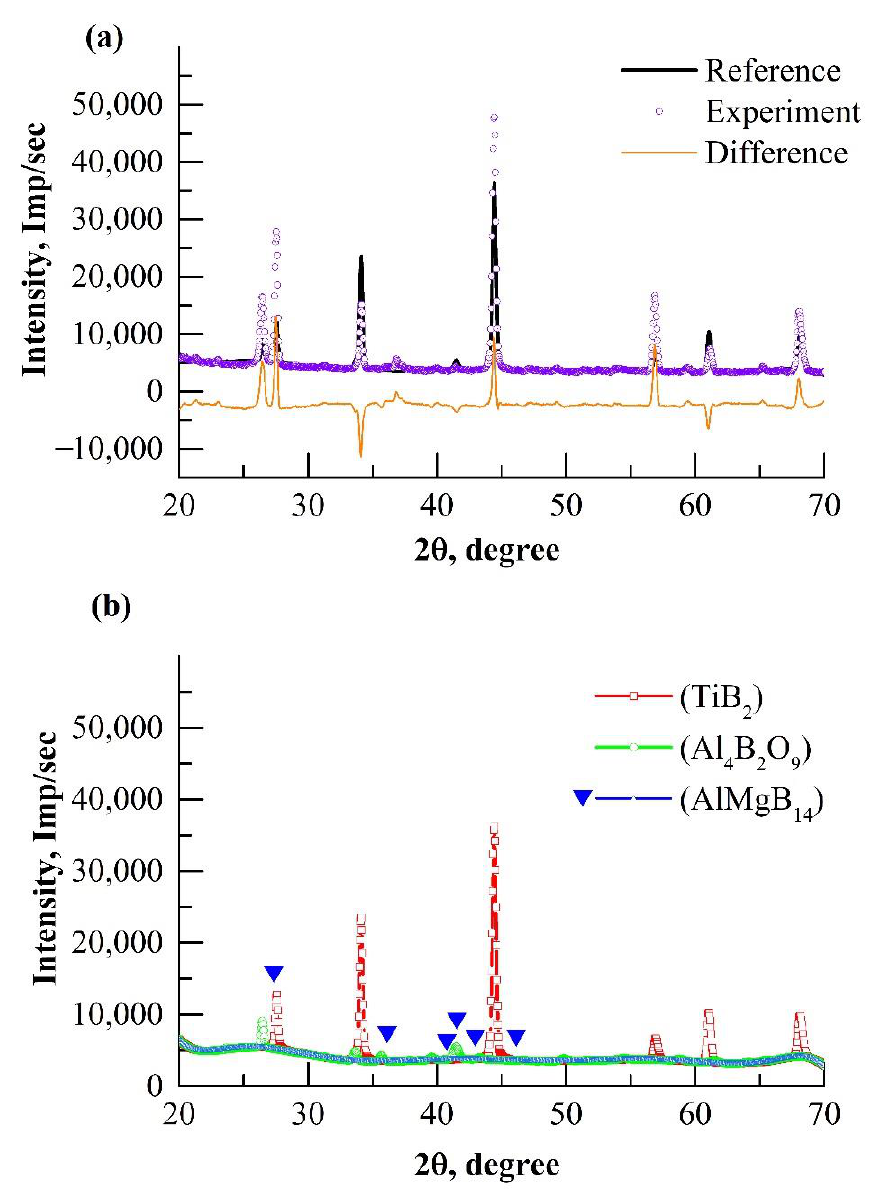
Figure 2. XRD patterns of the spark plasma sintered AlMgB 14 -TiB 2 composite: ( a ) reference and experimental XRD patterns; ( b ) XRD patterns of the phases, found by the Rietveld method.